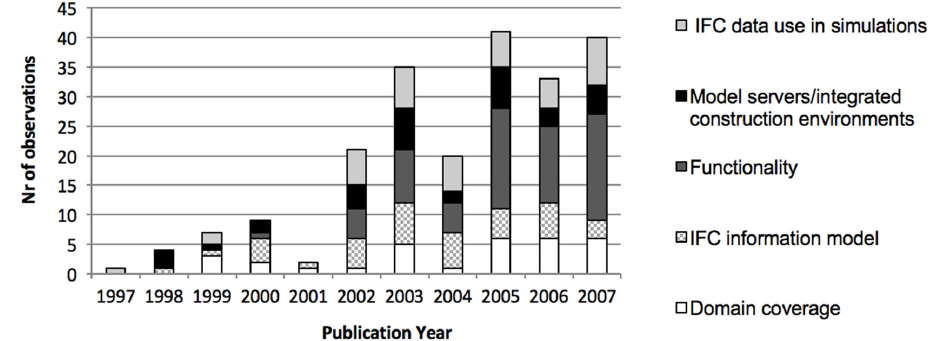
Figure 5. Applied research: extending the usability of the IFC standard.